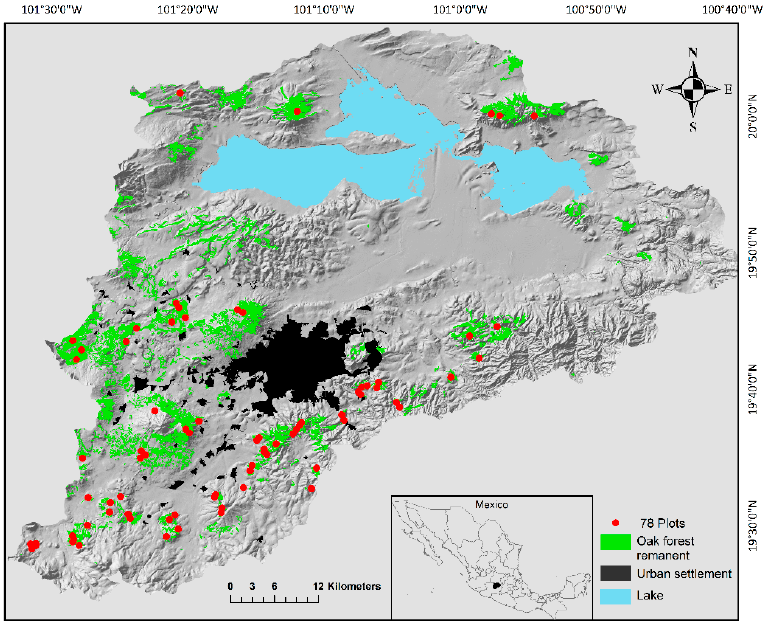
Figure 1. The Cuitzeo lake basin in Michoacán, Mexico. In the map, oak forest remnants are indi- cated in green and the locations of 78 plots (census units) in red dots . The location of each unit was defined by the presence of oak forests. In each plot we registered each tree of oak species in a 2000 m 2 area [43]. The oak forests remanent were identified by analyzing the 2008 vegetation layer